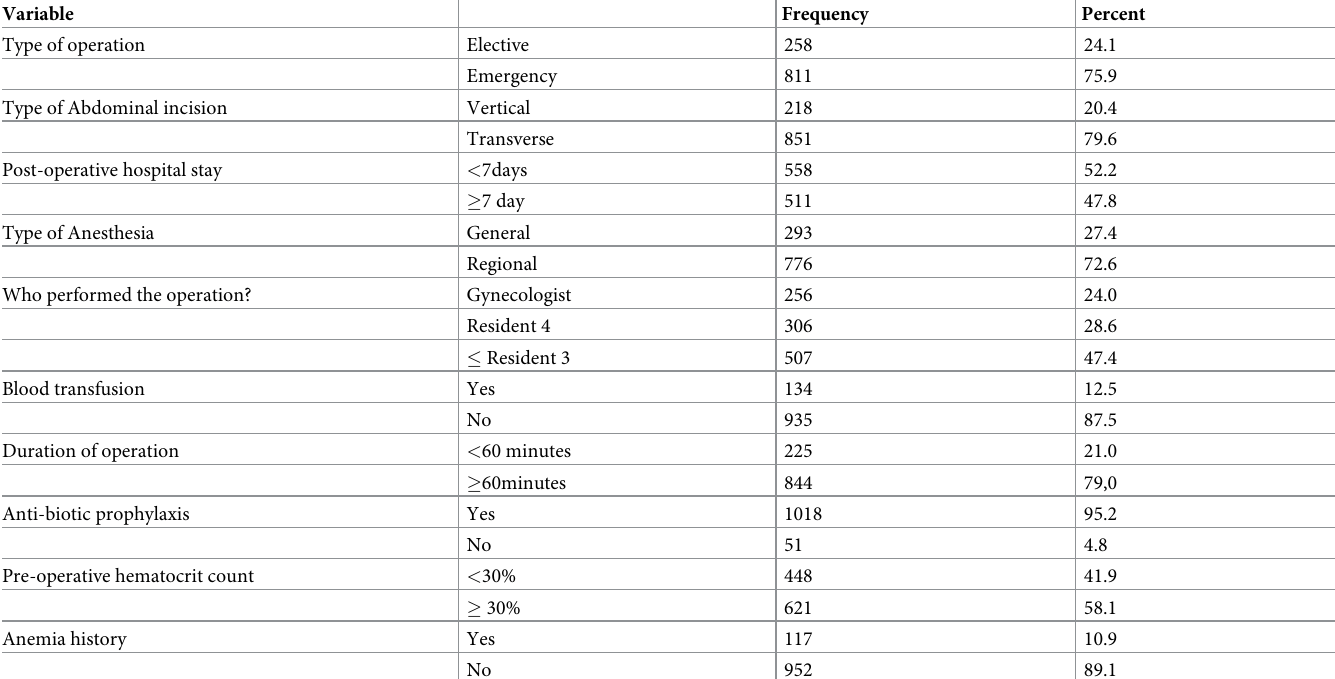
Table 2. Operational characteristics women for whom cesarean section was conducted in two public hospitals in Harar city, East